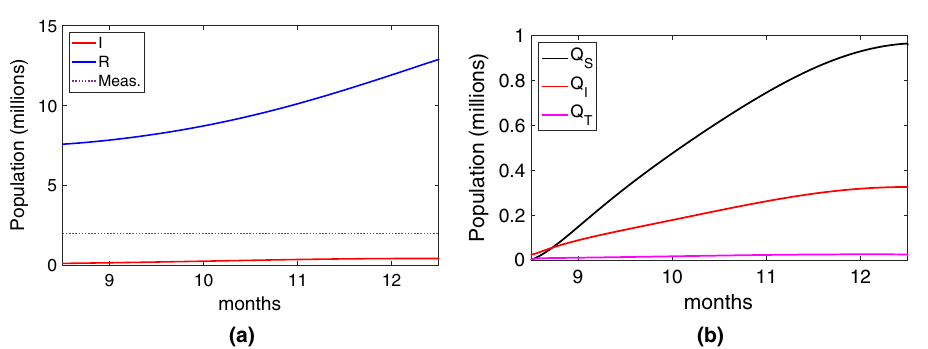
Figure 7. Efficiency of the contact tracing application considering an adoption ratio of 0.7. ( a ) Infected and recovered individuals under the real scenario; ( b ) People quarantined; ( c ) People quarantined when the precision is increased to FPR = 0.1 and TPR = 0.8 .